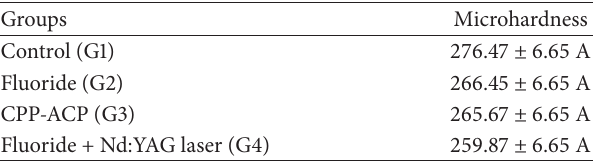
Table 2: Mean surface Knoop microhardness (KHN) values and standard error for the factor